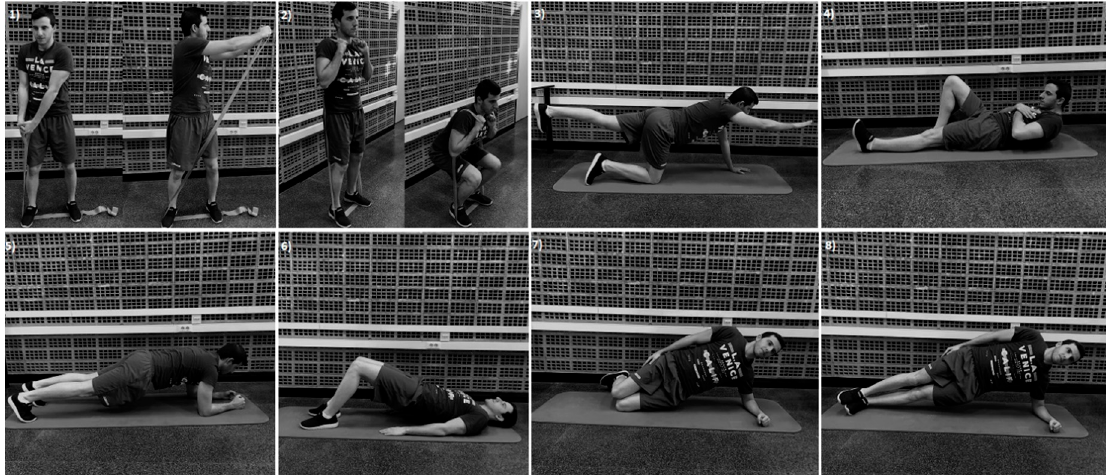
Figure 1. Exercises performed: 1) Torso-twist, 2) Squat, 3) Bird-dog, 4) Modified curl-up, 5) Front plank/front plank with brace, 6) Supine plank, 7) Lateral knee plank and 8) Lateral plank.